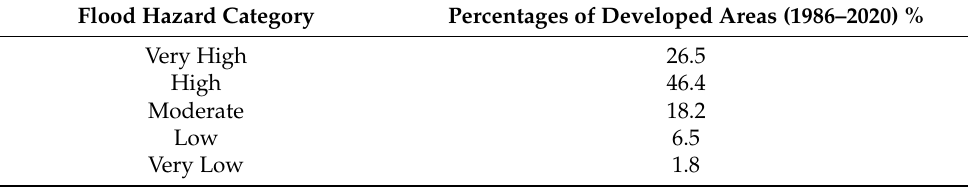
Table 8. Analysis of changes in flood hazard